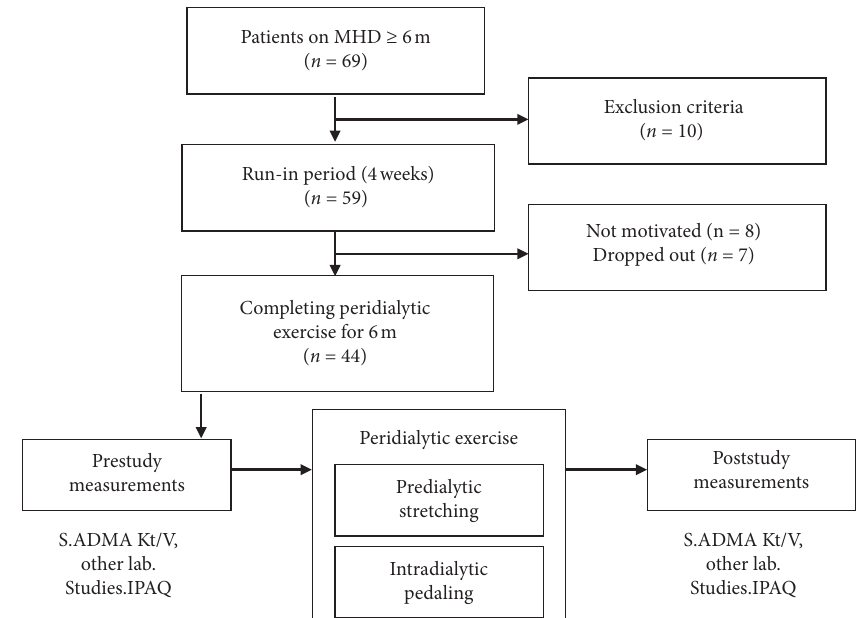
Figure 1: Study flowchart. MHD: maintenance haemodialysis; IPAQ: International Physical Activity